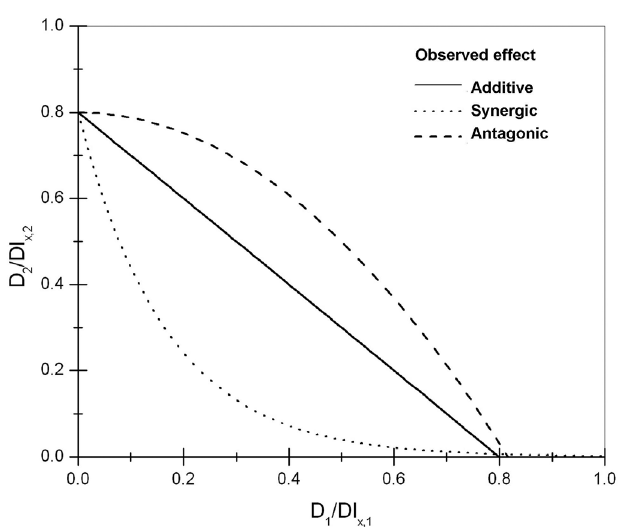
FIGURE 1 - Generic example of an iso-effect curve – isobologram, which demonstrates the presence of synergy or antagonism between two therapeutic agents. X and Y axes: ratio between the dose of combined agents 1 and 2 to the dose of 1 and 2 in isolation, for the same biological